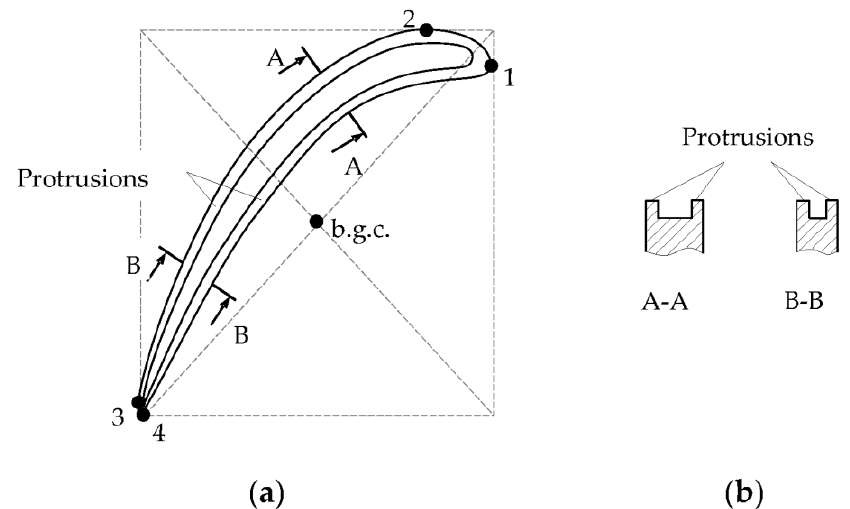
Figure 7. View of the turbine blade tip from the stator side: conditional blade’s geometric center (b.g.c.) ( a ) and its cross-sections A-A and B-B ( b ).